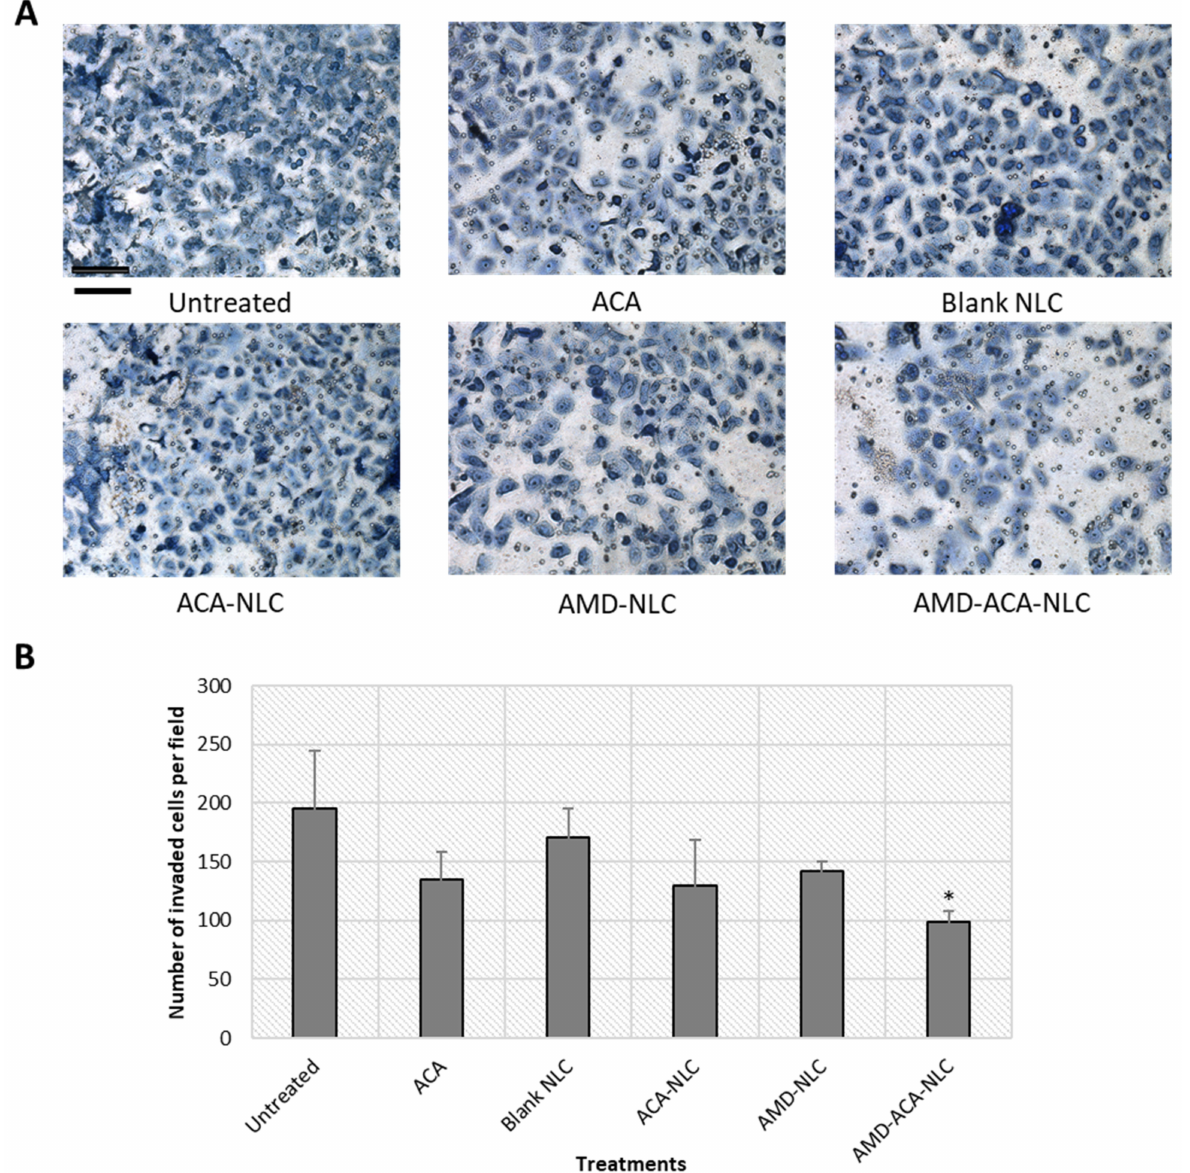
Figure 7. Invasion assay conducted on PC-3 cell lines without treatment or with ACA, blank NLC, ACA-NLC, AMD-NLC, and AMD-ACA-NLC treatments. ( A ) Representative images of transwell inserts. Scale bar = 50 µ m. ( B ) Number of invaded cells per field after different treatments. Significant differences in number of invaded cells compared to the untreated are marked with * p < 0.05. All data are shown as mean ± S.D. of three independent